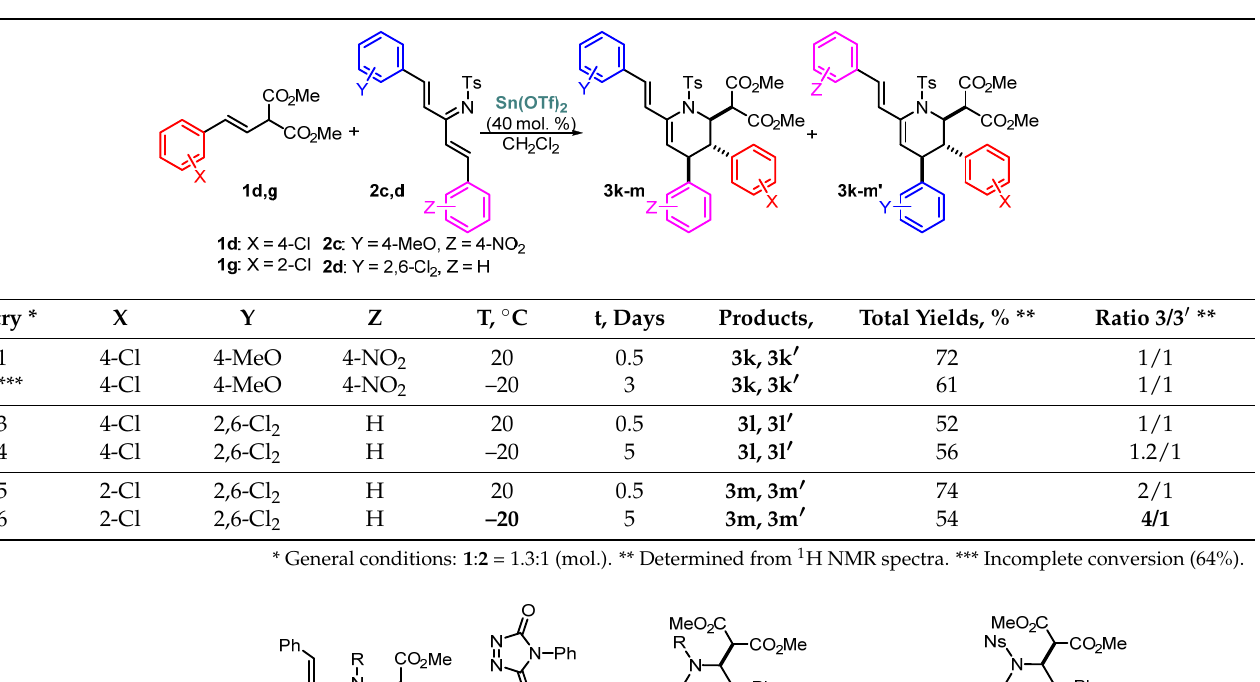
Table 1. The reaction of unsymmetrically substituted azatrienes 2c,d with styrylmalonates 1d,g .